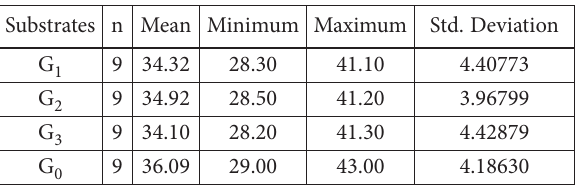
Table 4. Average temperature values measured by substrates (°C) Substrates n Mean Minimum Maximum Std. Deviation